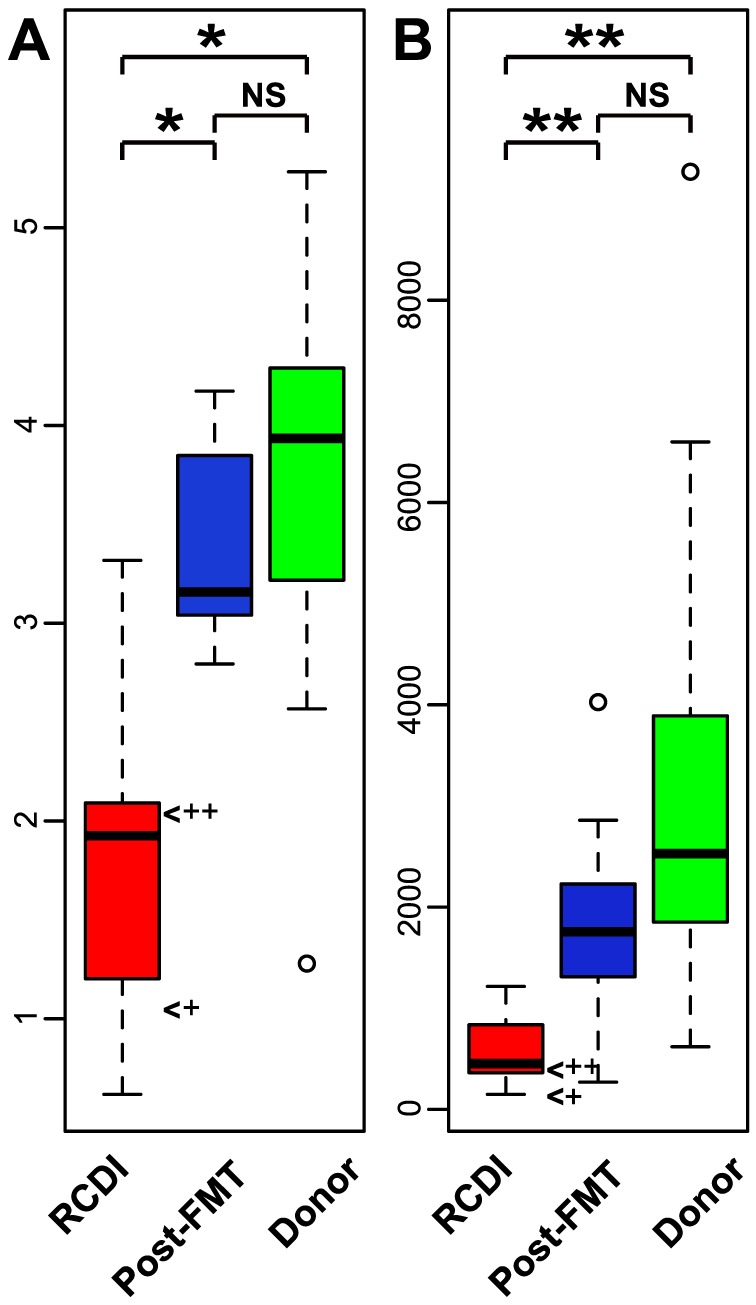
Microbiota diversity (Shannon) and richness (ACE) of RCDI and post-FMT patient and donor samples.(A) Shannon index; (B) ACE index. Significant differences are shown (*, p<0.01; **, p<0.001) as measured by Wilcoxon rank sum test. RCDI samples from patient #6a (+), who experienced antibiotic-induced relapse and was treated by FMT again as patient #6b (++) are marked.